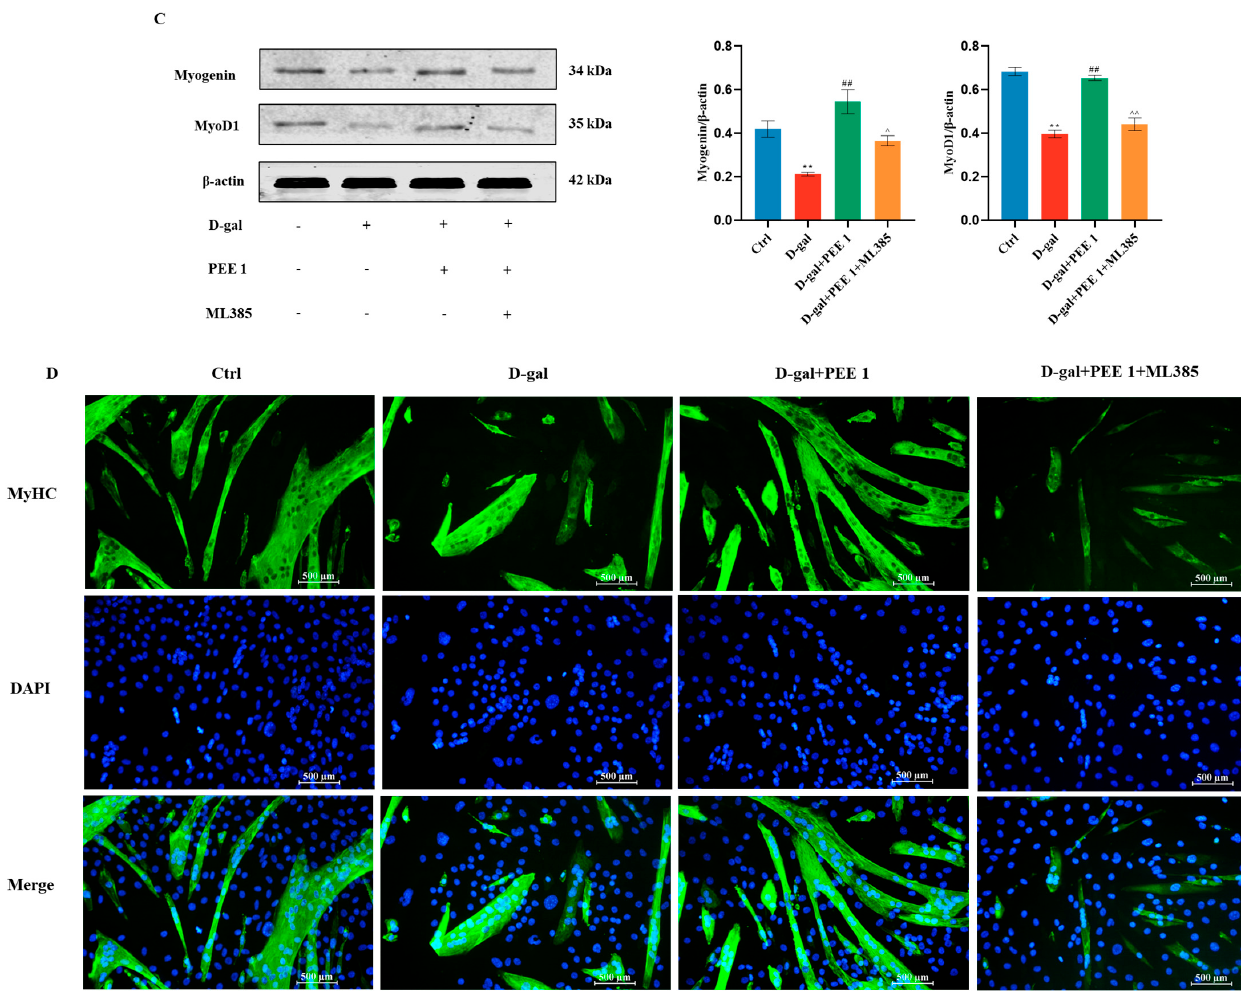
Figure 4. PEE protected C2C12 from oxidative damage through Nrf2/HO − 1 signaling pathway. ( A ) ML385 treatment reversed the role of PEE in promoting nuclear translocation of Nrf2 in C2C12 cells. ( B ) ML385 treatment reversed the alleviating e ff ect of PEE on senescence in C2C12 cells. ( C ) ML385 treatment abolished the ameliorative effect of PEE on D-gal-induced differentiation capacity of C2C12 cells. ( D ) ML385 treatment reversed the myotubular fusion-promoting effect of PEE. All data are expressed as mean ± SEM (n = 3). * p < 0.05 and ** p < 0.01 vs. Ctrl; # p < 0.05 and ## p < 0.01 vs. D-gal; ˆ p < 0.05 and ˆˆ p < 0.01 vs. D-gal + PEE 1.